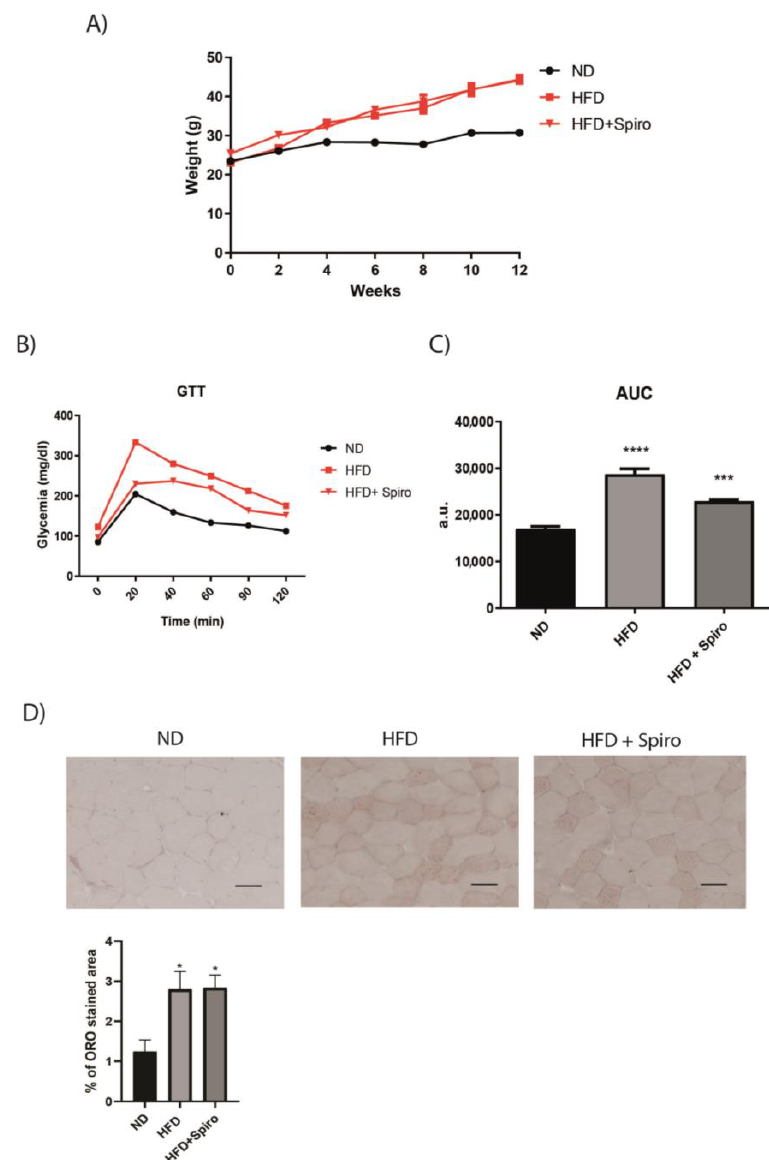
Figure 1. Spironolactone prevents impaired glucose intolerance without affecting body weight gain in mice fed a high-fat diet. ( A ) Body weight over the course of the study (n = 10). ( B ), Plasma glucose levels during the intraperitoneal glucose tolerance test (IPGTT) following food withdrawal for 6 h (n = 10). ( C ), The area under the curve (AUC) of glucose using the trapezoidal rule (n = 10). ( D ), Oil Red O staining on tibialis anterior. Representative sections from the tibialis anterior of all groups (n = 6, scale bar 50 µ m). * p < 0.05 vs. ND; *** p < 0.001 vs. HFD; **** p < 0.0001 vs. ND. Values are expressed as means ±